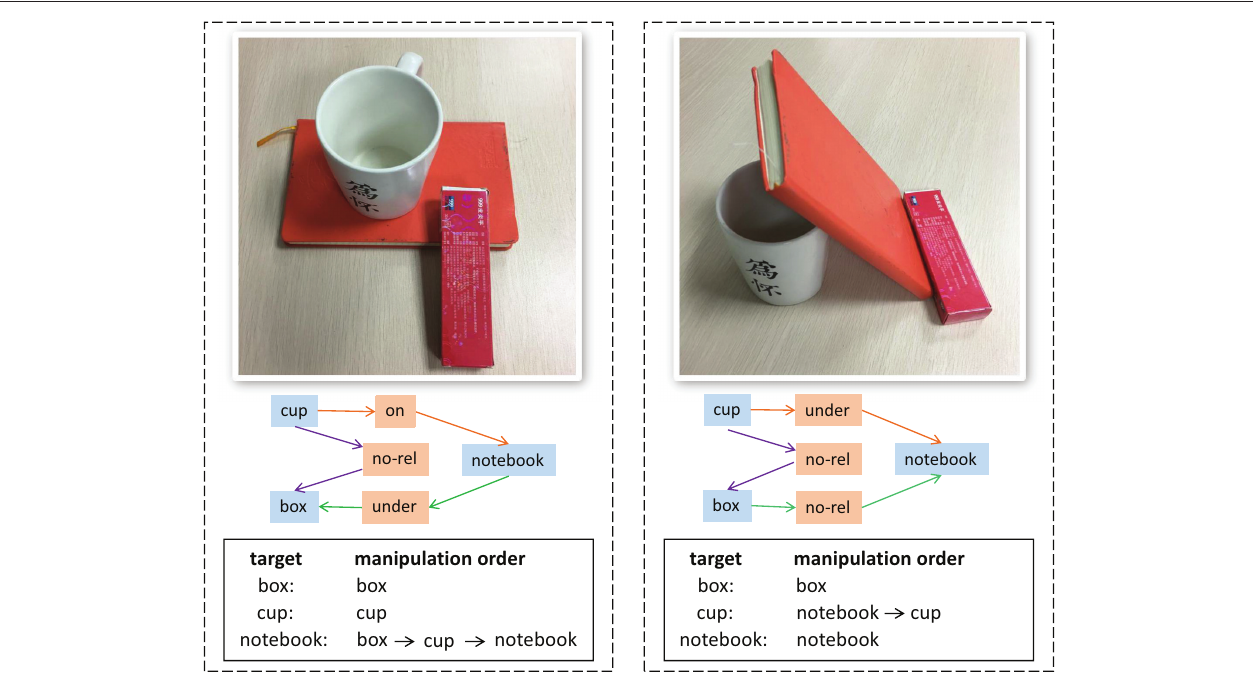
FIGURE 1 | The influence of different relationships between objects on manipulation order. The first row is the object-stacking scene, the second is the object relationship graph, and the third is the manipulation order of target